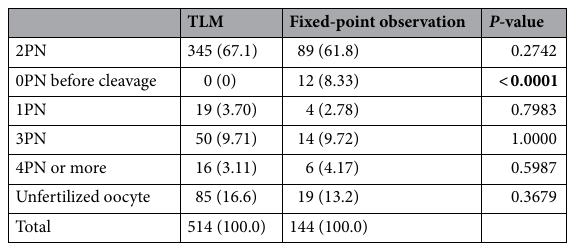
Table 2. Pronuclei observation in each group. An unfertilized oocyte is defined as 0PN with cessation of cleavage. Data are shown as numbers (percentages). PN pronuclei; TLM time-lapse monitoring.